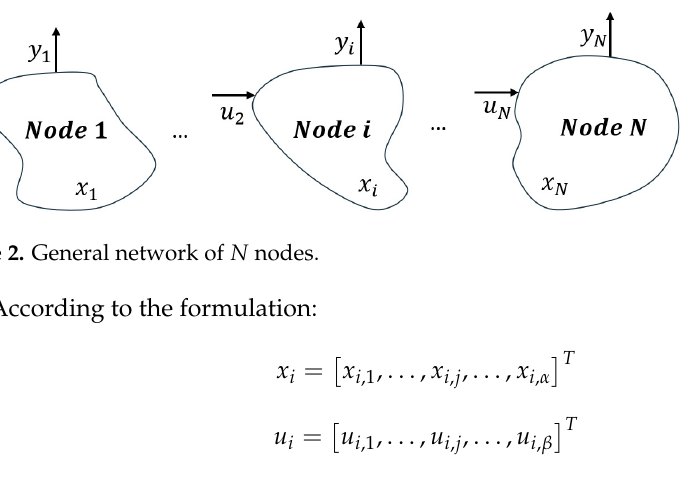
Figure 1. MPC scheme.